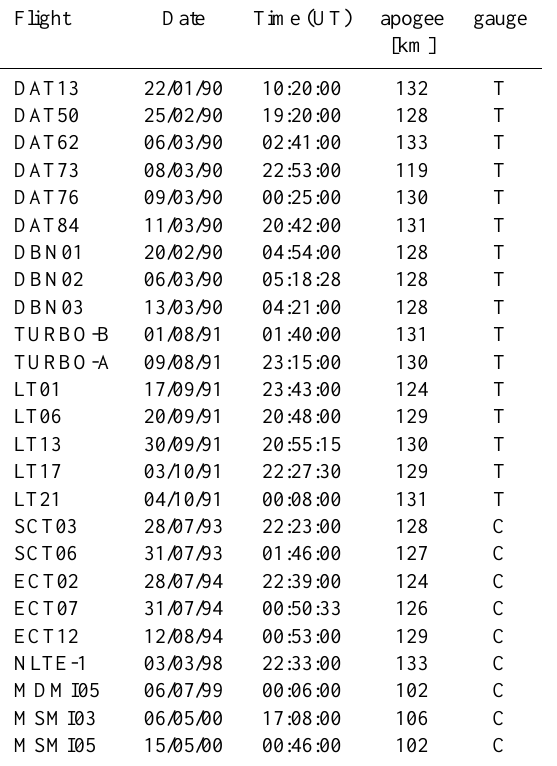
Table 1. Listing of all TOTAL and CONE flights. In the last column the gauge type is indicated: T: TOTAL, C: CONE